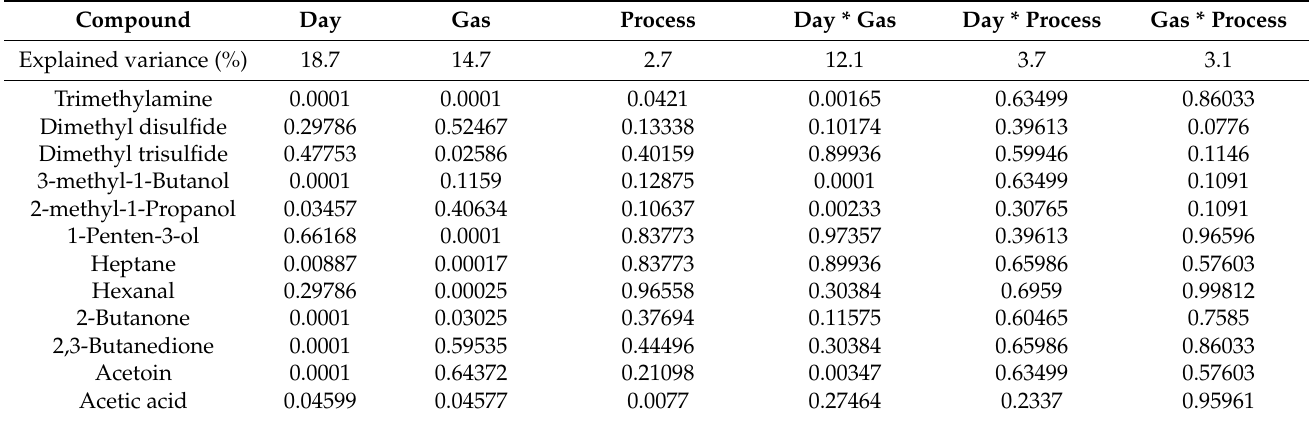
Table A6. 5050 manova results for selected volatile organic compounds. The table shows the false discovery rate (FDR) adjusted p -values for each of the terms included in the model. The "*" is showing the